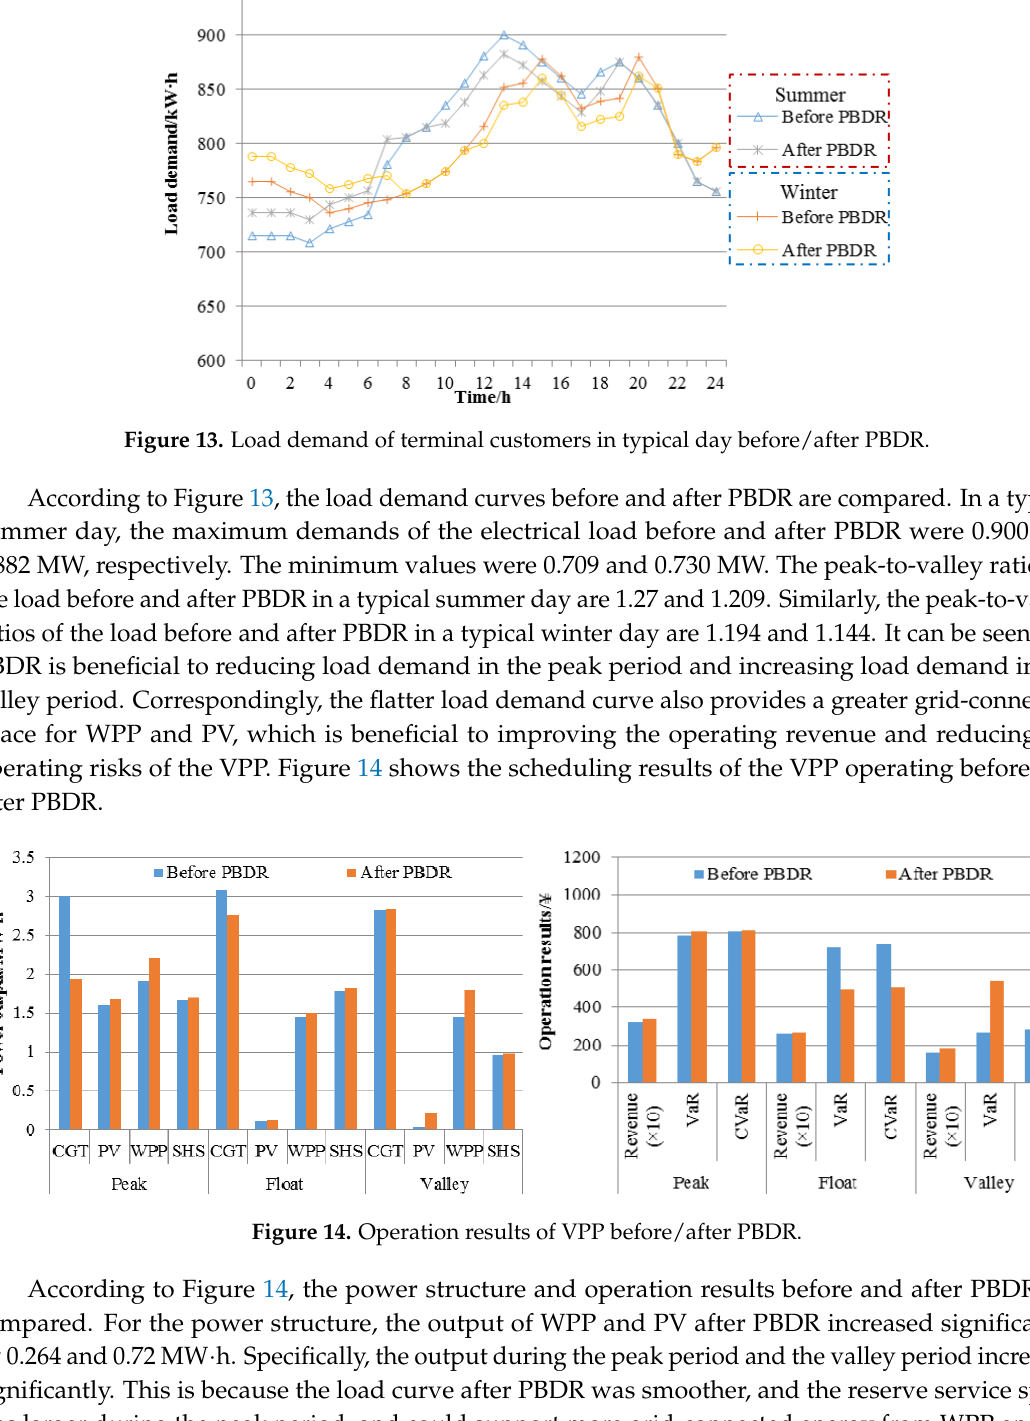
Figure 14. Operation results of VPP before/after PBDR.